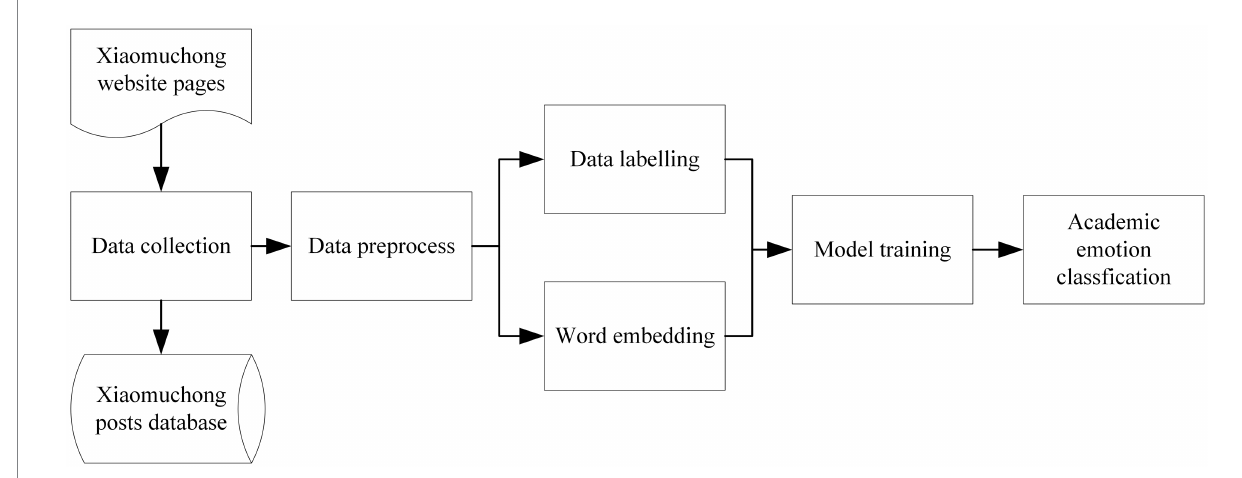
FIGURE 1 Academic emotion recognition data process pipeline.